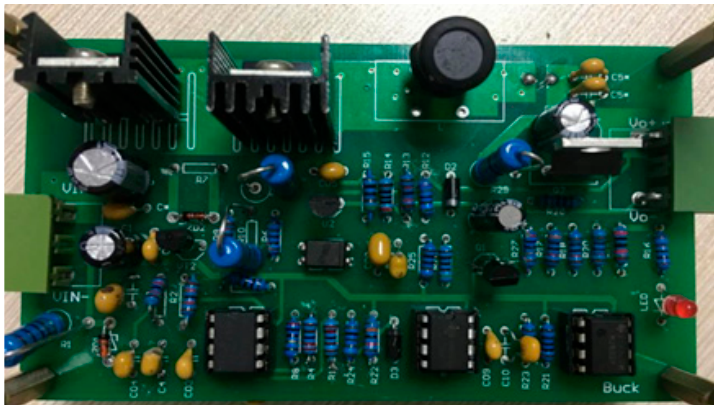
Figure 7. The experimental prototype.